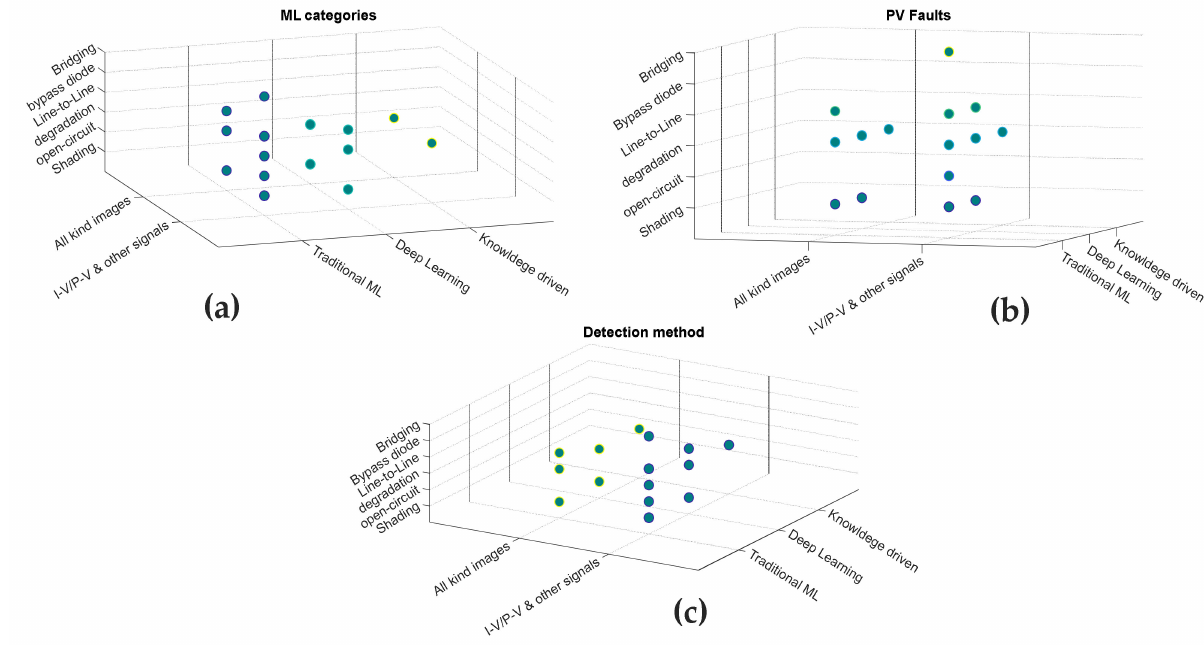
Figure 11. An overview of data distribution analysis for ML tool applications in CM of PV systems: ( a ) ML categories; ( b ) PV fault types; ( c ) detection method